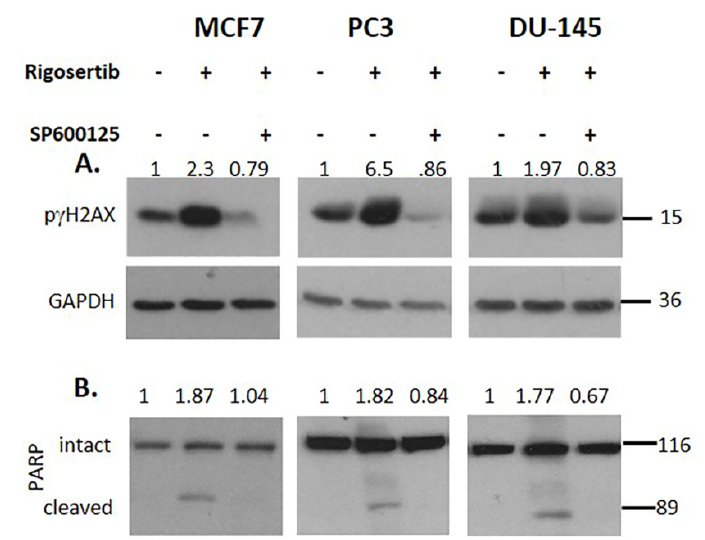
Figure 4. Rigosertib-mediated tumor cell killing is reduced by JNK1 / 2 inhibition. Representative Western blots documenting the effect of SP600125 treatment (20 μ M, added one h before Rigosertib) on γ H2AX phosphorylation ( A ) and PARP cleavage ( B ) in MCF7, PC3 and DU-145 cells. Rigosertib was applied for 18 h at a concentration of 50 µM). Numbers on top of the blot indicate the fold change in protein phosphorylation upon Rigosertib treatment (normalized to loading control) relative to DMSO (solvent) treated control samples. All experiments have been repeated at least three times with consistent results. A representative blot is shown.